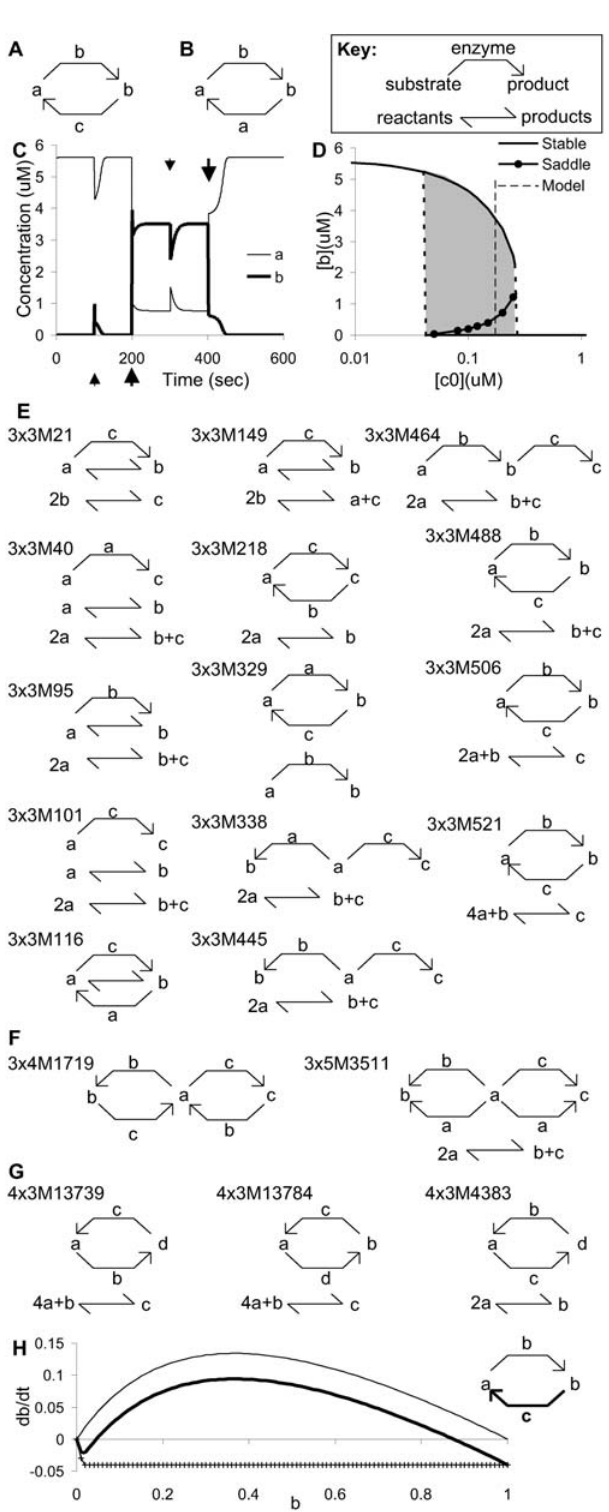
Figure 2. Example Bistable Models. (A) The simplest configuration, 3 6 2M101, i.e., having 3 molecules, 2 reactions, and being the 101st configuration in this class. (B) A simpler model that is bistable with Michaelis–Menten/Briggs–Haldane kinetics, but not with a mass action explicit representation of the enzyme-substrate complex. (C) Time- course of response of 3 6 2M101 to perturbations. (D) Stability diagram of 3 6 2M101, as a function of c0 (initial concentration of c). The